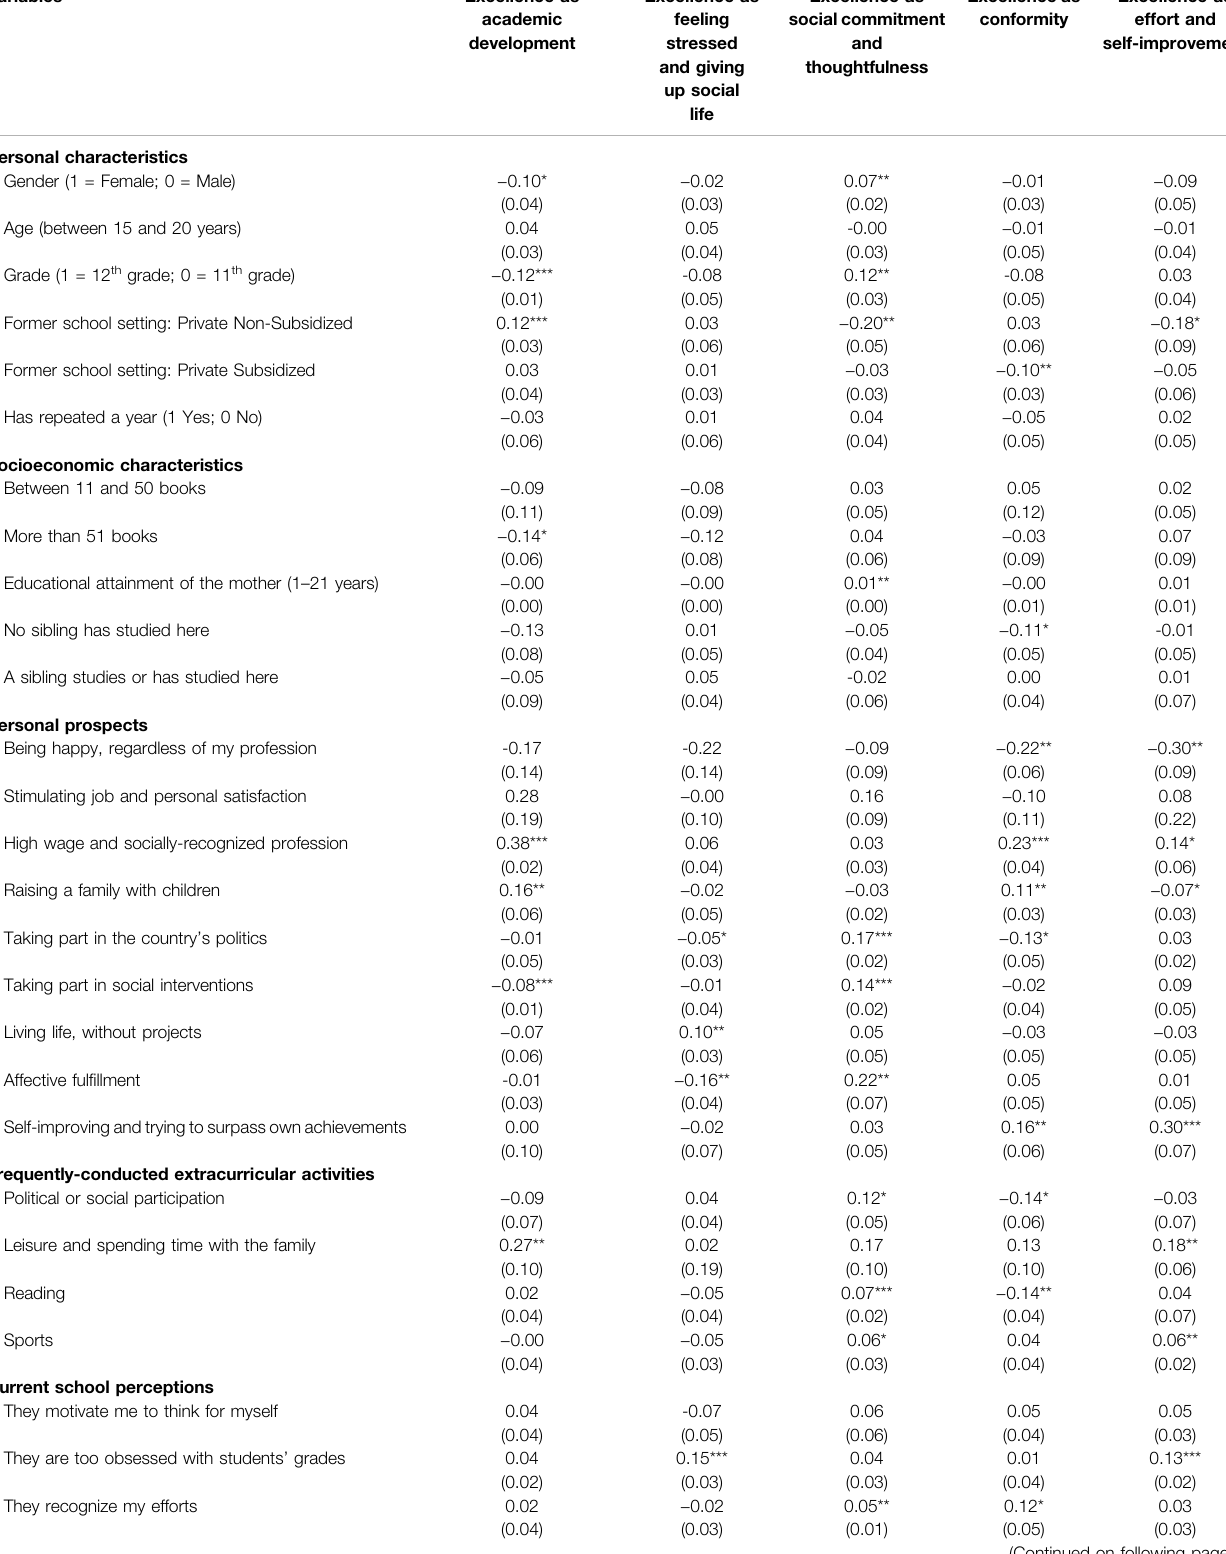
TABLE 5 | Regression models for indices on the notions of